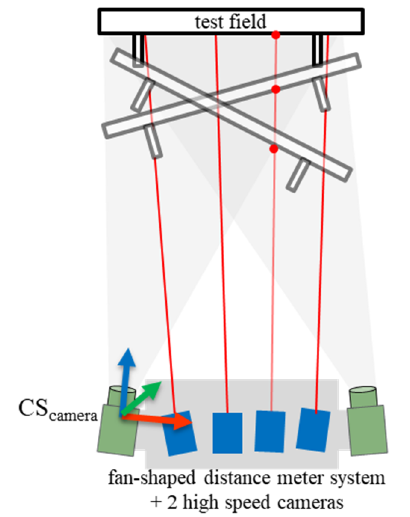
Figure 18. Concept of Method 2 for determining the relative orientation.